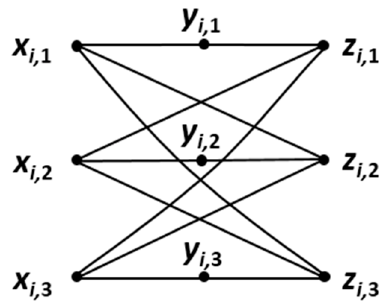
Figure 3. Subgraph produced from the i th clause of a one-in-three SAT instance.